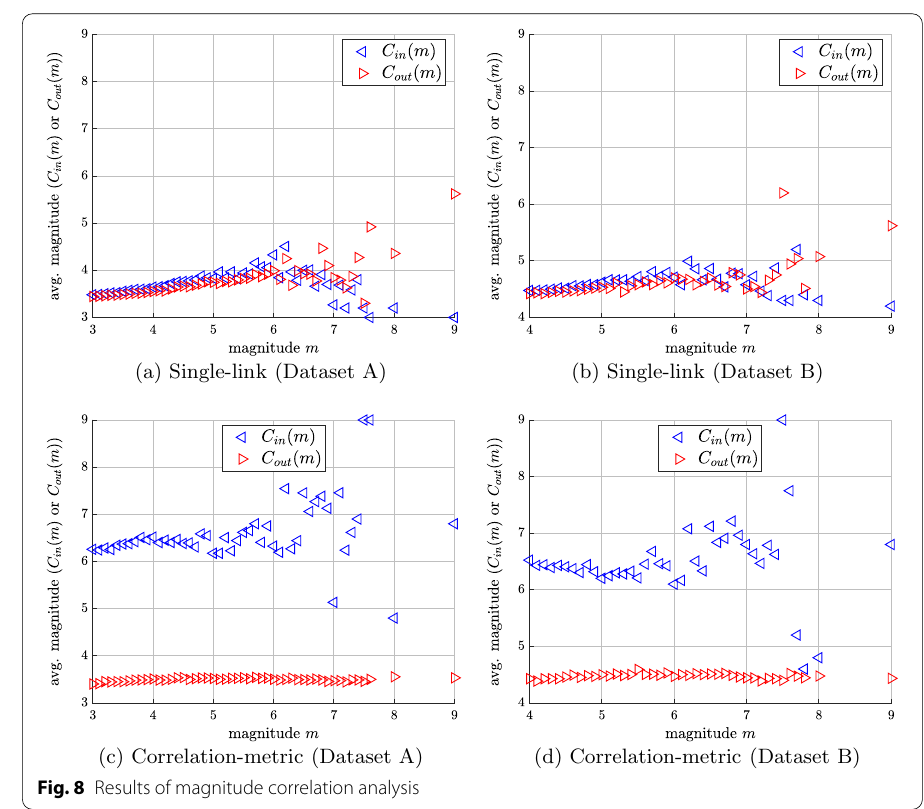
Fig. 8 Results of magnitude correlation